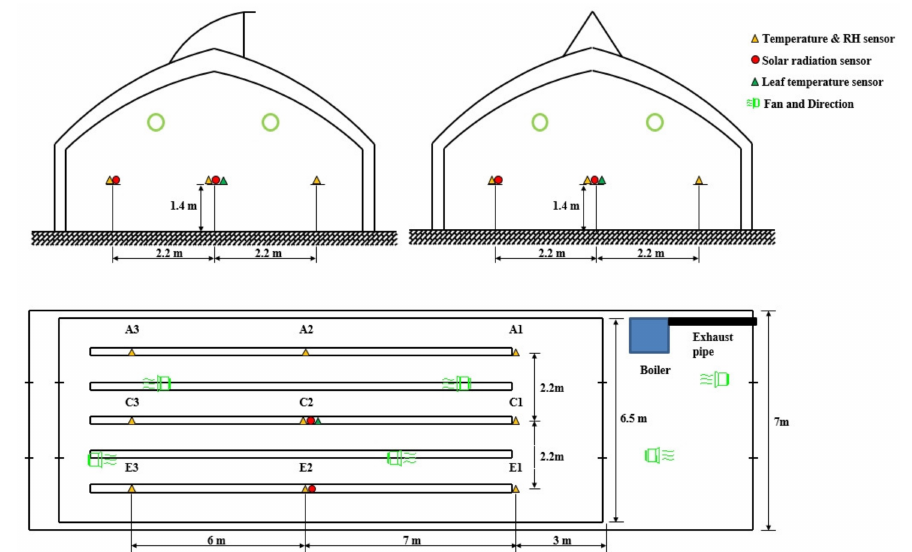
Figure 2. Position of sensors in the single-span